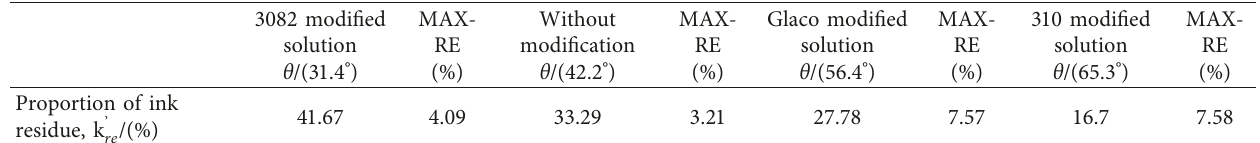
Table 8: Experimental values of ink residue under different